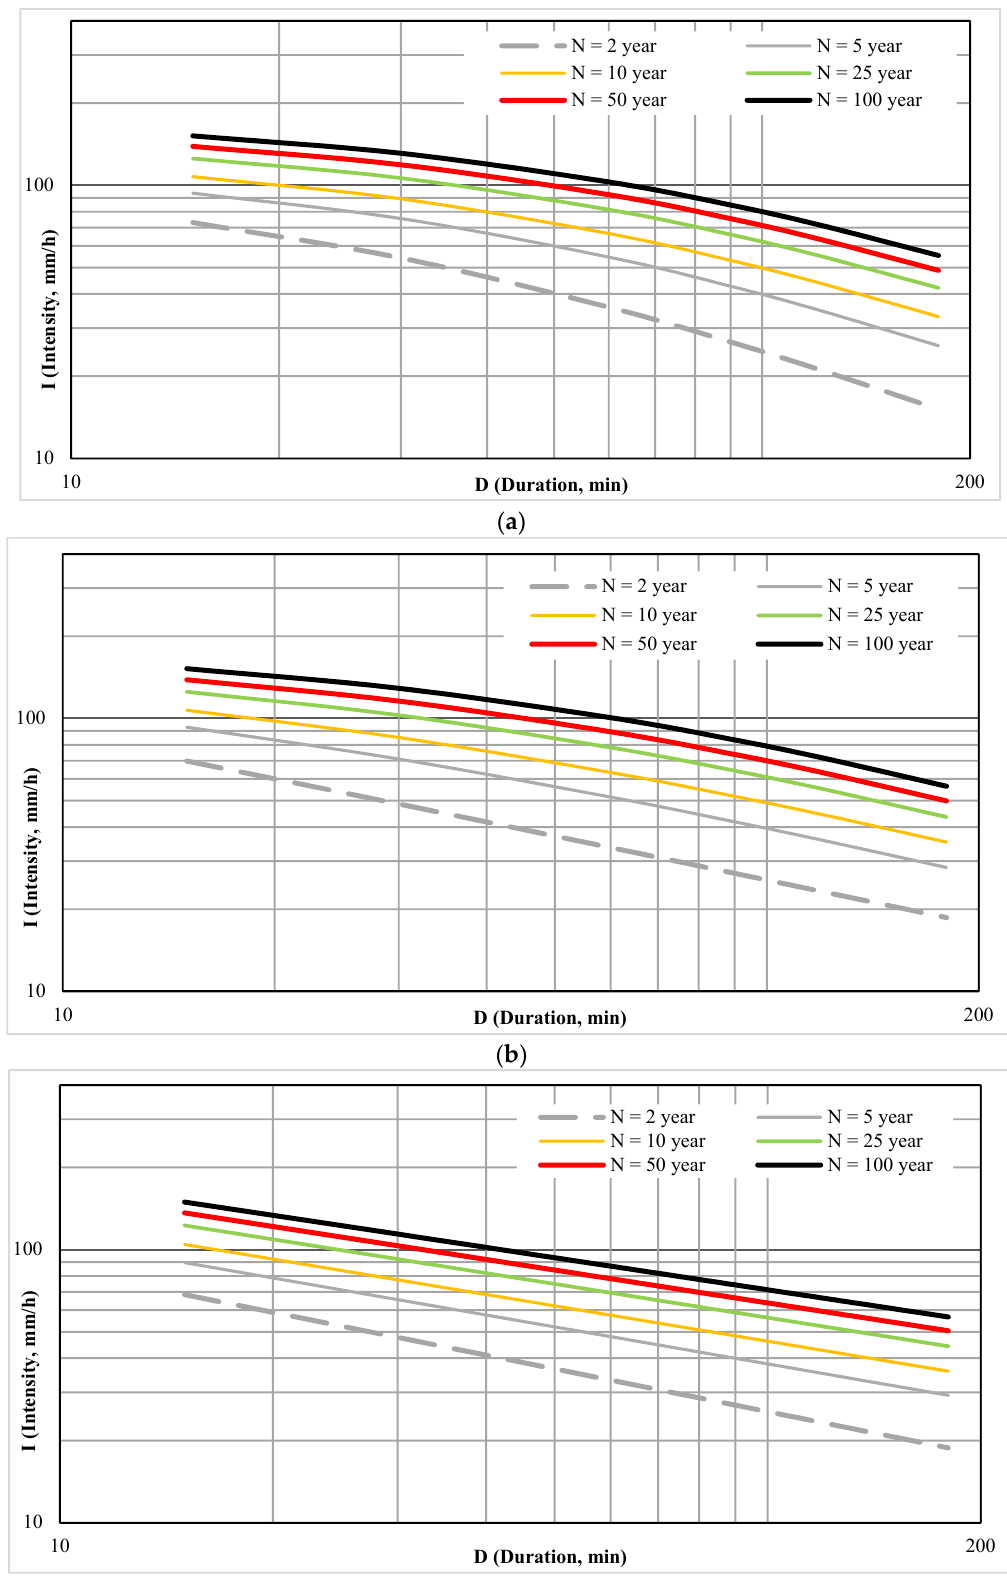
Figure 9. The IDF rainfall curves according to ( a ) Talbot, ( b ) Kimijima, and ( c ) Bermard.